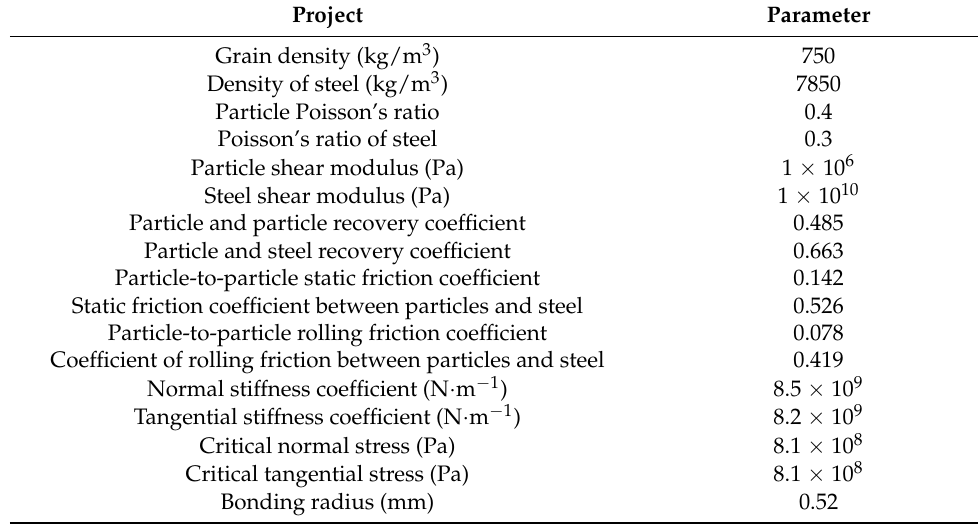
Table 1. Simulation model